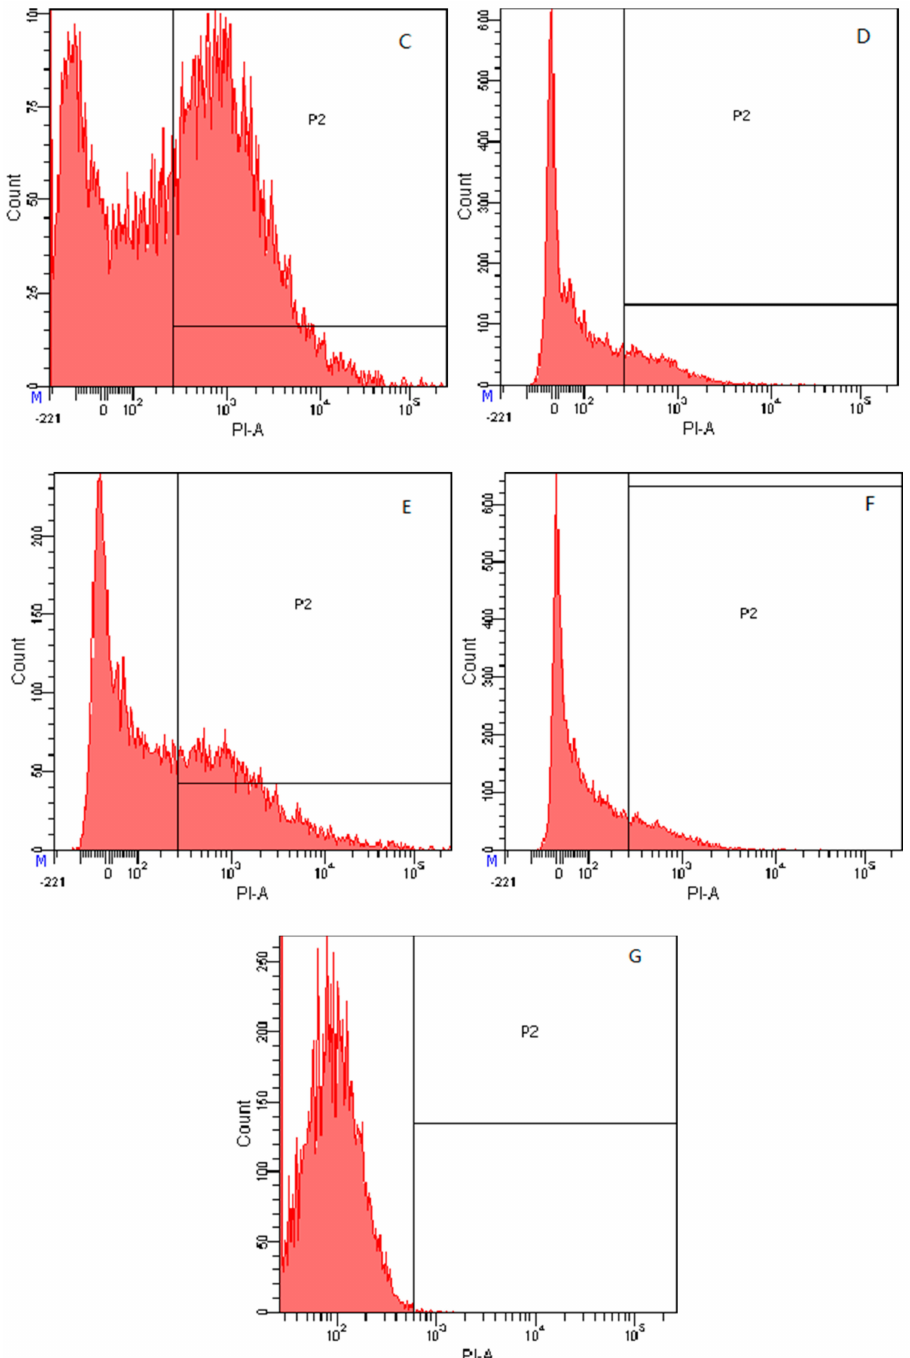
Figure 8. Membrane damage in E. coli ATCC25922 cells treated with the peptides as measured by an increase in fluorescence intensity of PI. ( A ) KW-WK 1 × MIC; ( B ) KW-WK 1/2 × MIC; ( C ) FP-PF 1 × MIC; ( D ) FP-PF 1/2 × MIC; ( E ) FW-WF 1 × MIC; ( F ) FW-WF 1/2 × MIC; ( G ) the control processed without